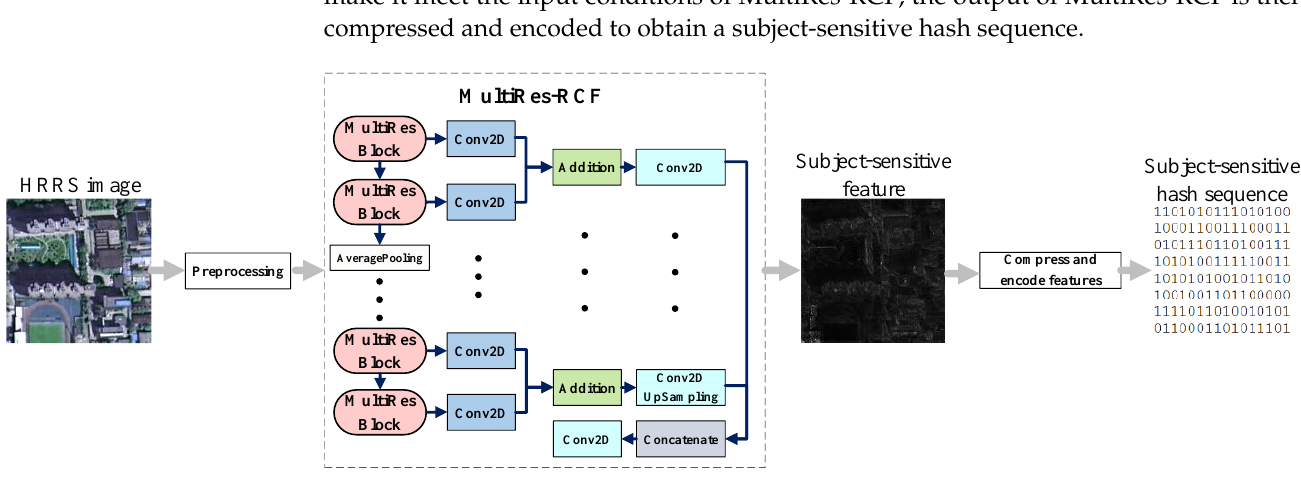
Figure 4. The structure of the proposed MultiRes-RCF networks (without encryption).